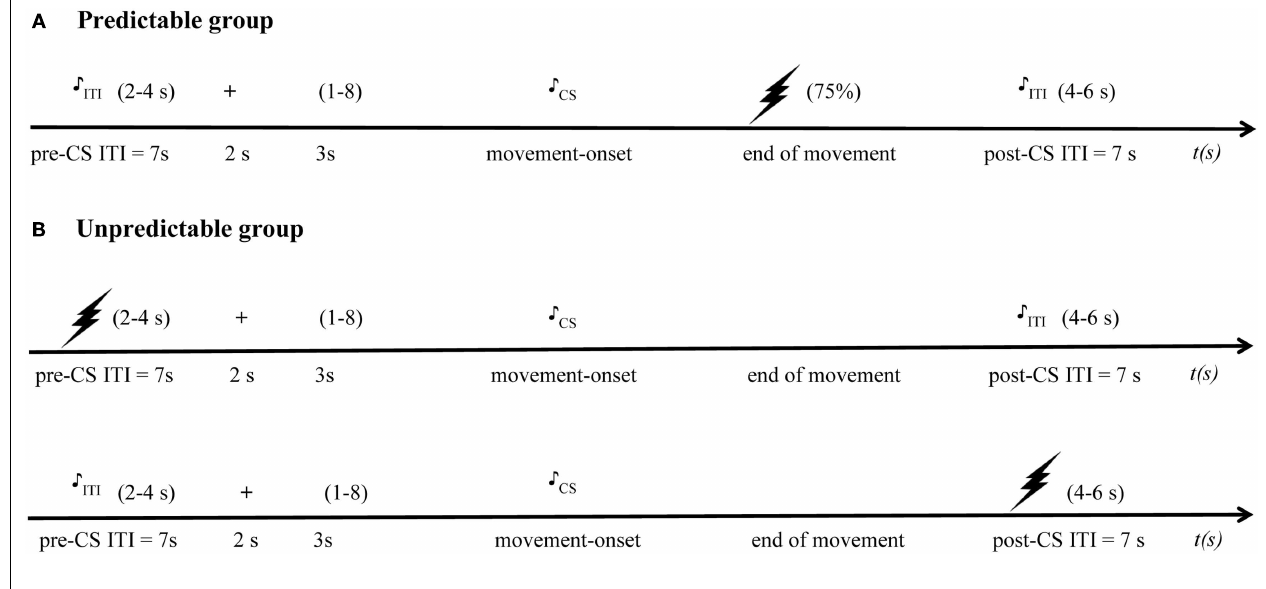
could be during the CS movement or during the pre-CS ITI or post-CS ITI. (B) In the unpredictable group pain-USs are delivered at the same rate either during the pre- or post-CS intertrial interval (ITI) and startle probes also could be presented during the CS movement or during the ITI – when the pain-US was presented in the pre-CS ITI, probes were presented in the post-CS ITI, and if the pain-US was presented during the post-CS ITI, probes were delivered during the pre-CS ITI. In both groups, no pain-USs were delivered during the generalization